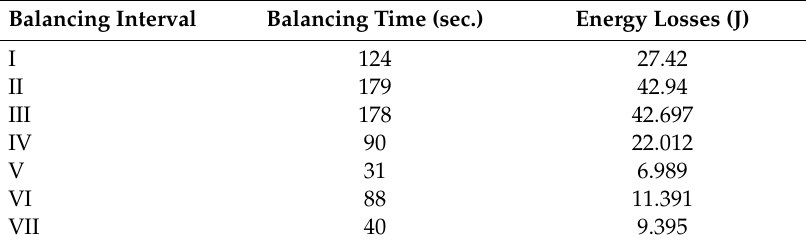
Figure 22. Battery’s voltage curve during fast charging balancing process. Table 4. Balancing time and energy loss in each interval.